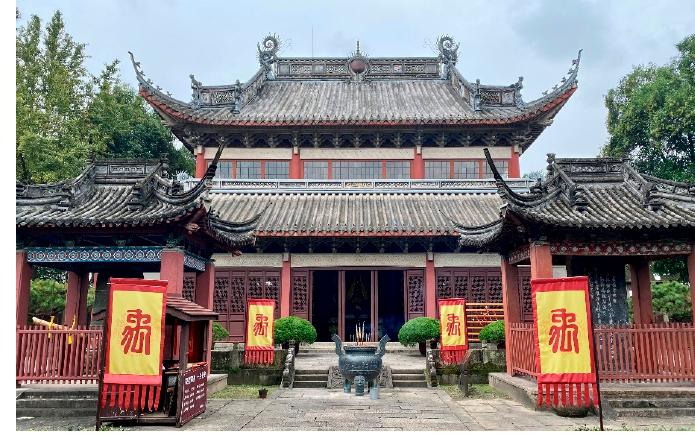
Figure 9. The picture of the Main Hall of the Tomb of Yu.